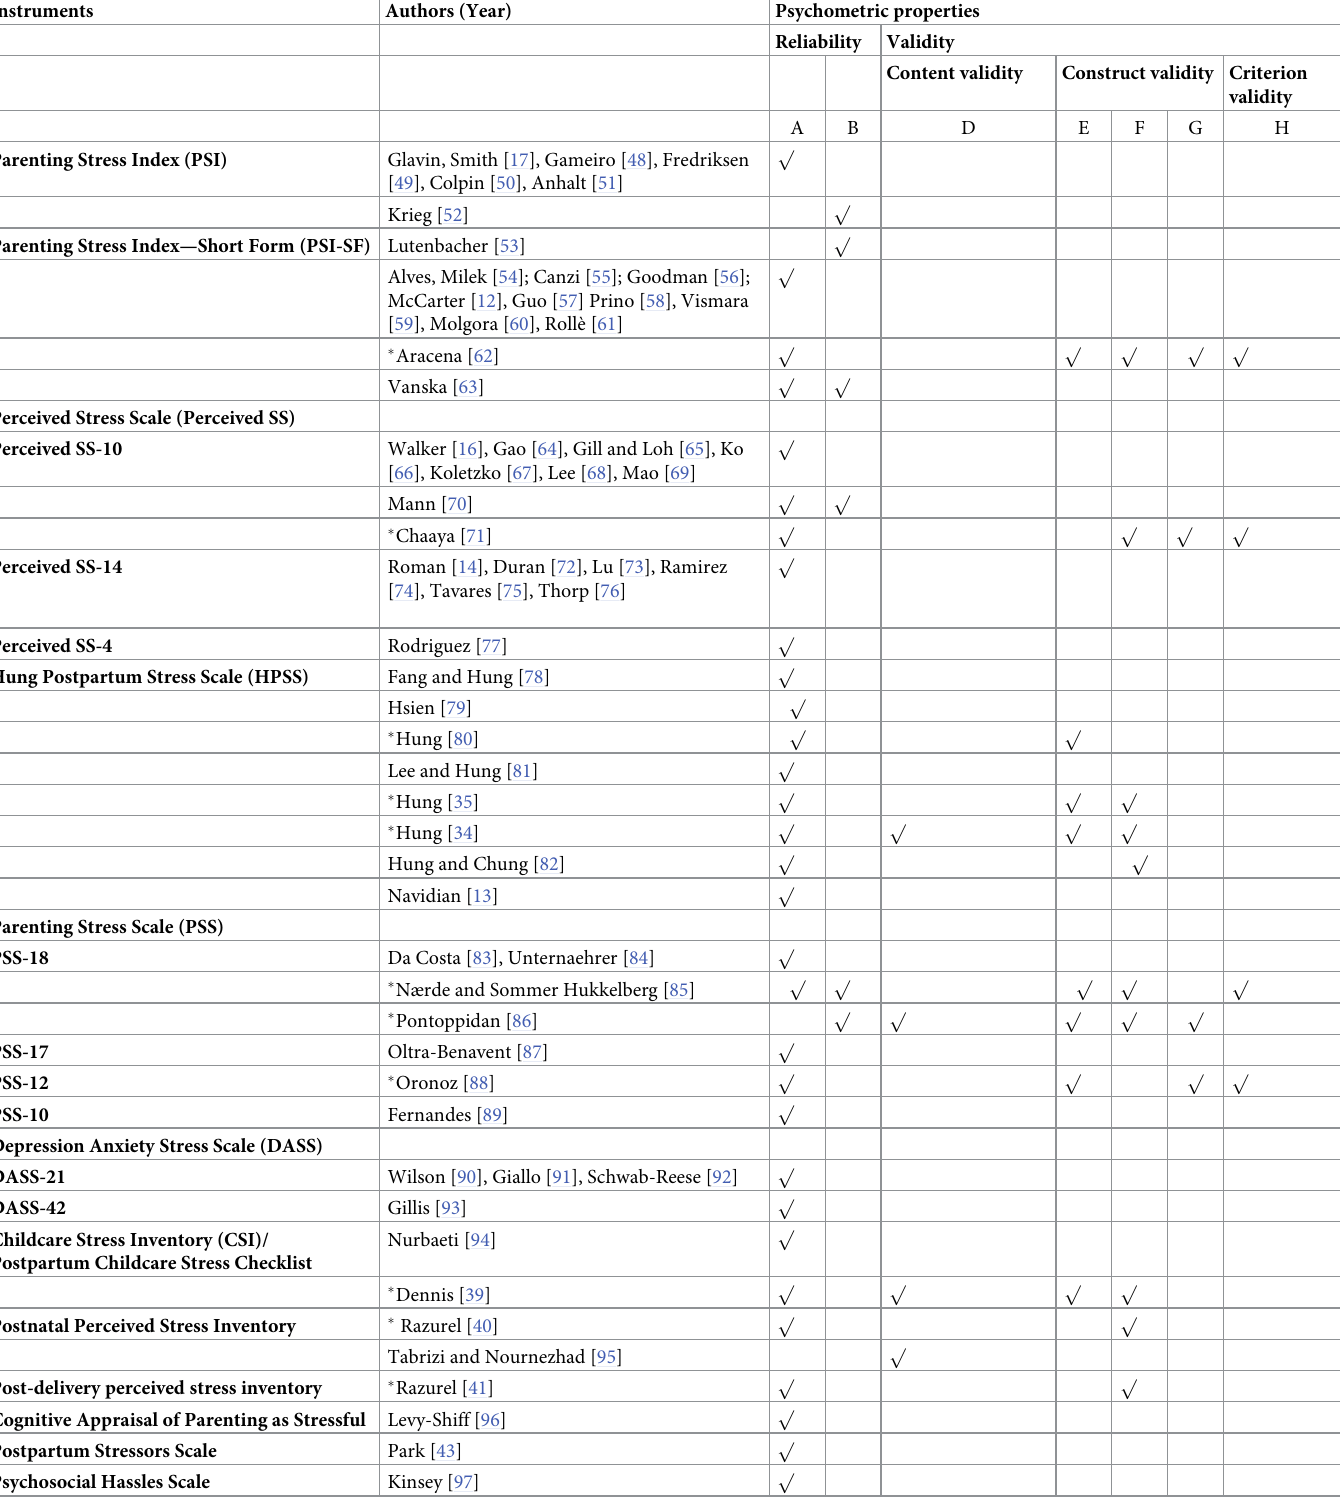
Table 3. Overview of psychometric properties for instruments